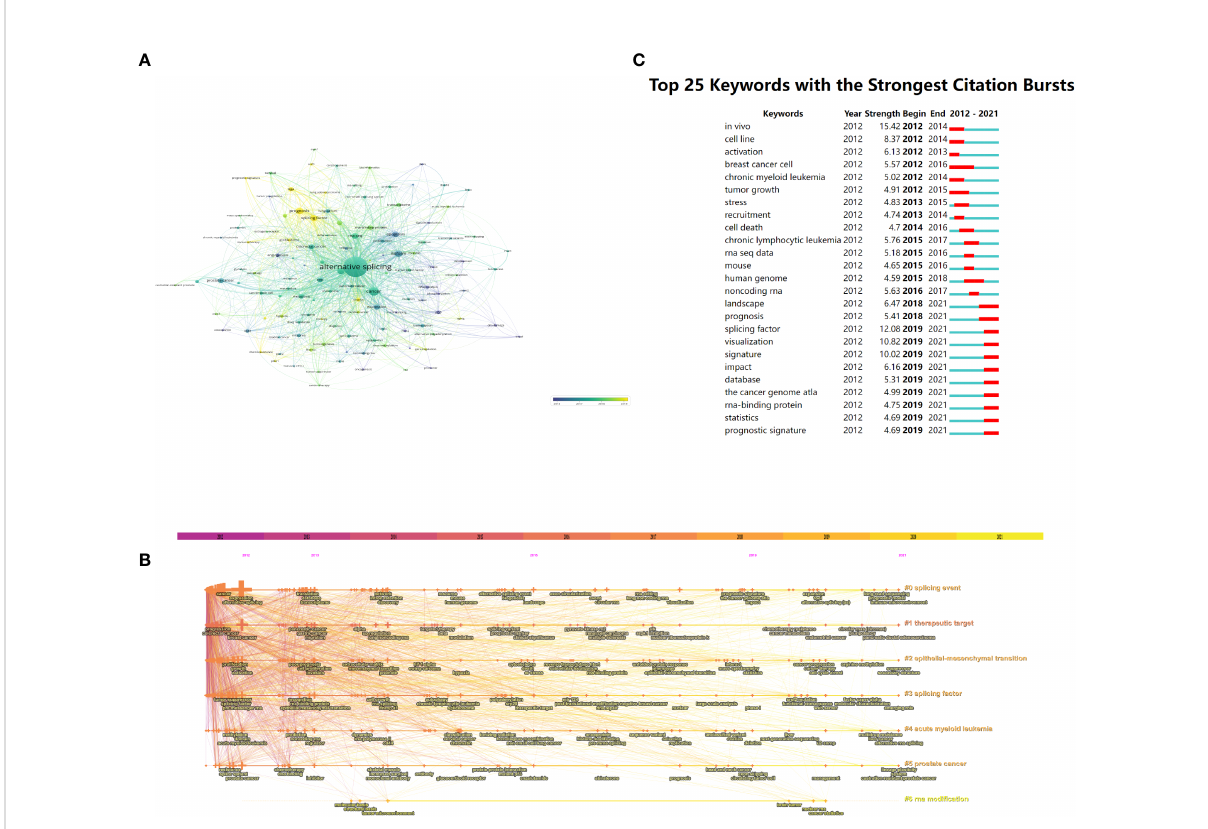
FIGURE 7 The (A) overlay map ( n ≥ 10, max lines = 1,000) and (B) timeline view of keywords associated with alternative splicing of cancer. (C) Greatest citation bursts for the top 25 keywords (sorted by the starting year). (A) The color of the node represents the average publication year, the